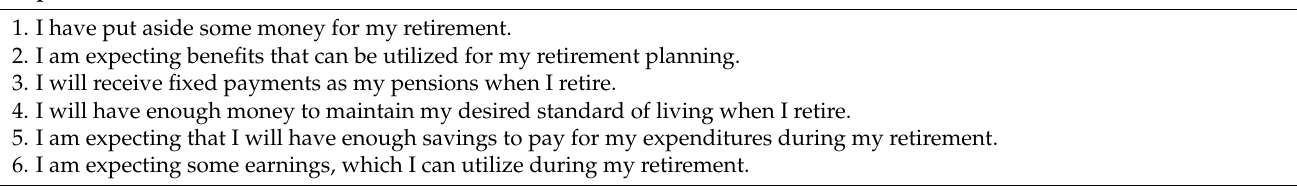
Table 2. Summary of the Measurement